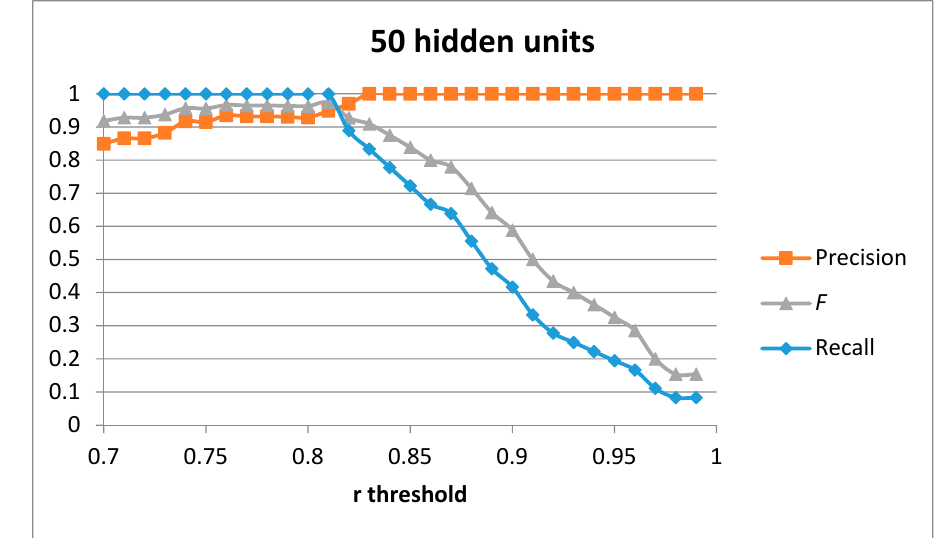
Figure 6. Precision, recall, and F score for 1 auto-encoder and 50 hidden units.